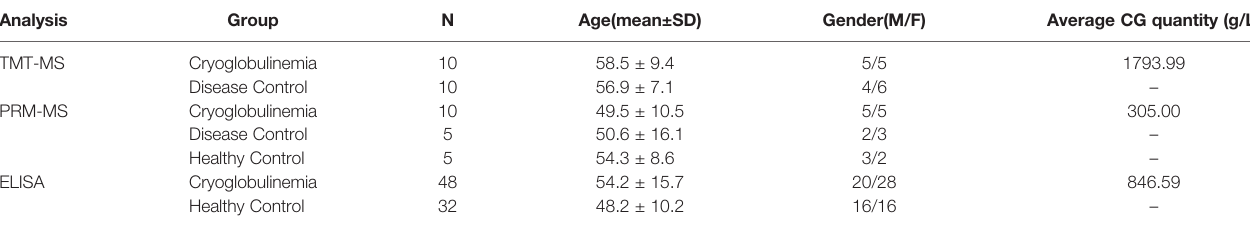
TABLE 1 | Clinical characteristics of enrolled subjects.